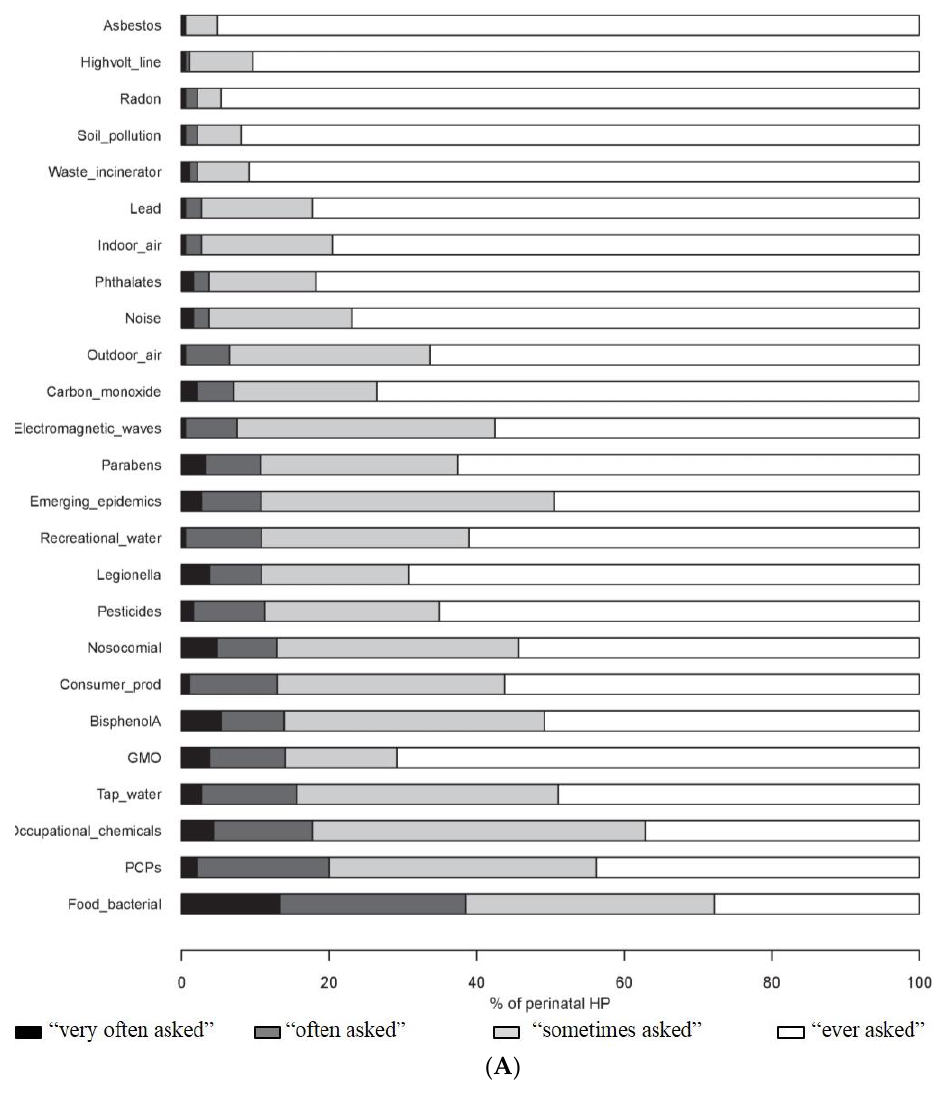
Figure 3. Cont . Figure 3.